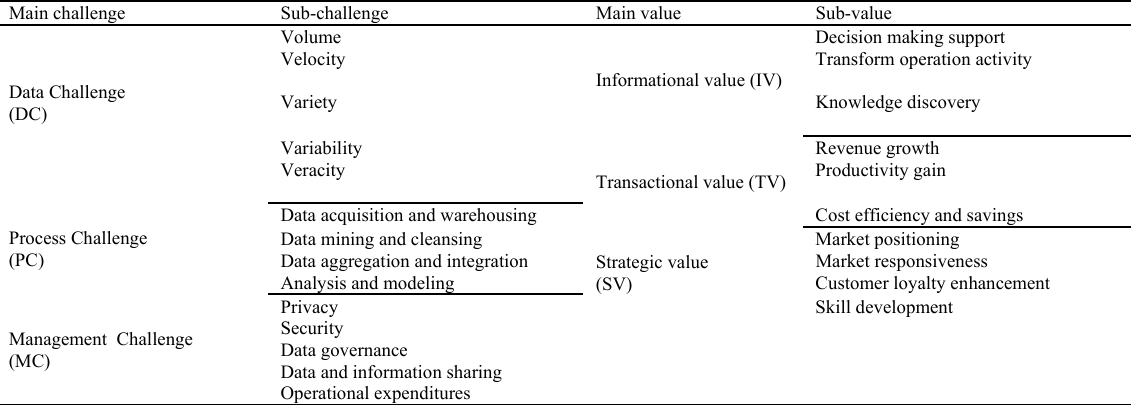
Fig. 1. Proposed approach to evaluate big data applications in e-commerce Big data challenges and values in e-commerce